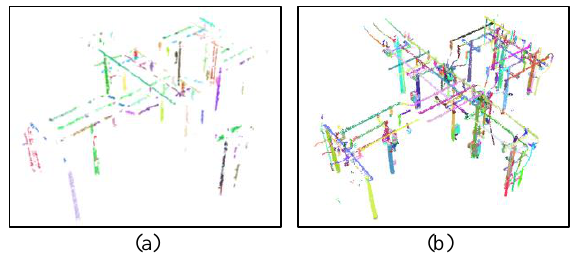
Figure 10. Parameter-domain pole-like feature segmentation results: (a) from a single TLS scan and (b) from multiple registered TLS scans